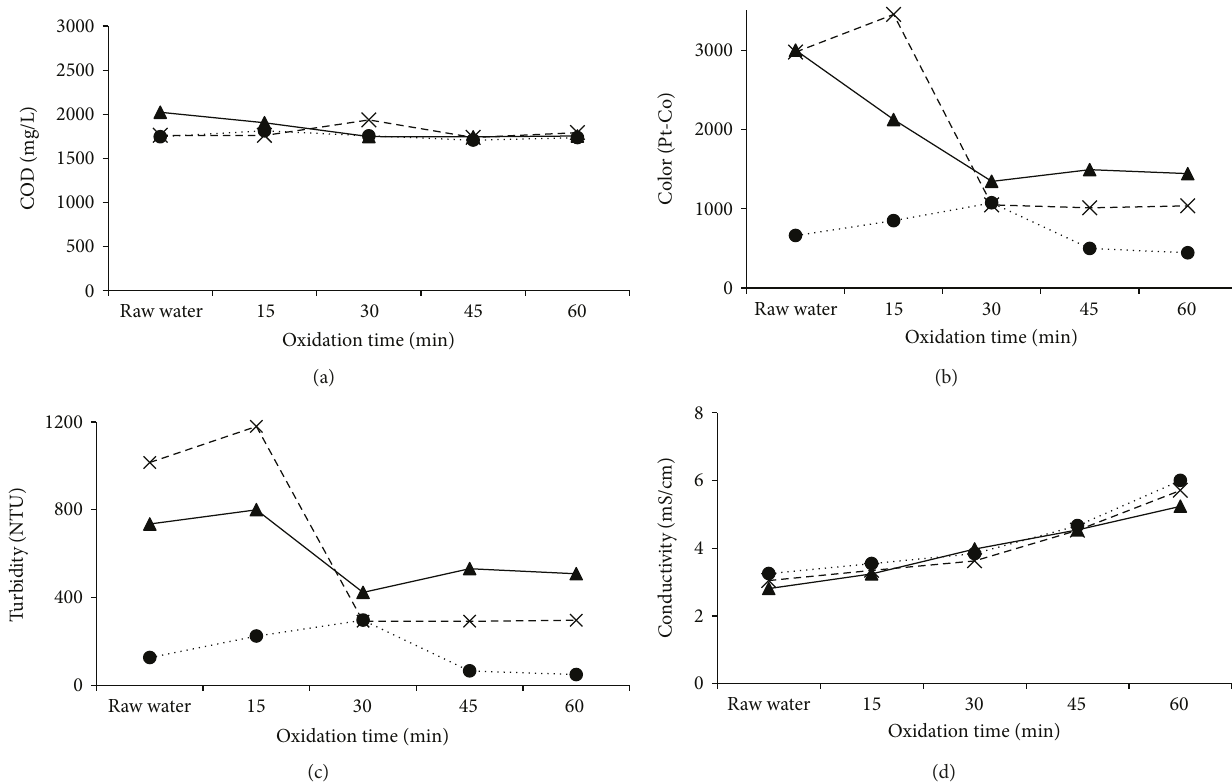
Figure 7: Behavior of (a) COD, (b) color, (c) turbidity, and (d) conductivity, with Salix babylonica contact at initial time ( ▲ ), 8 days ( × ), and 15 days ( ● ).